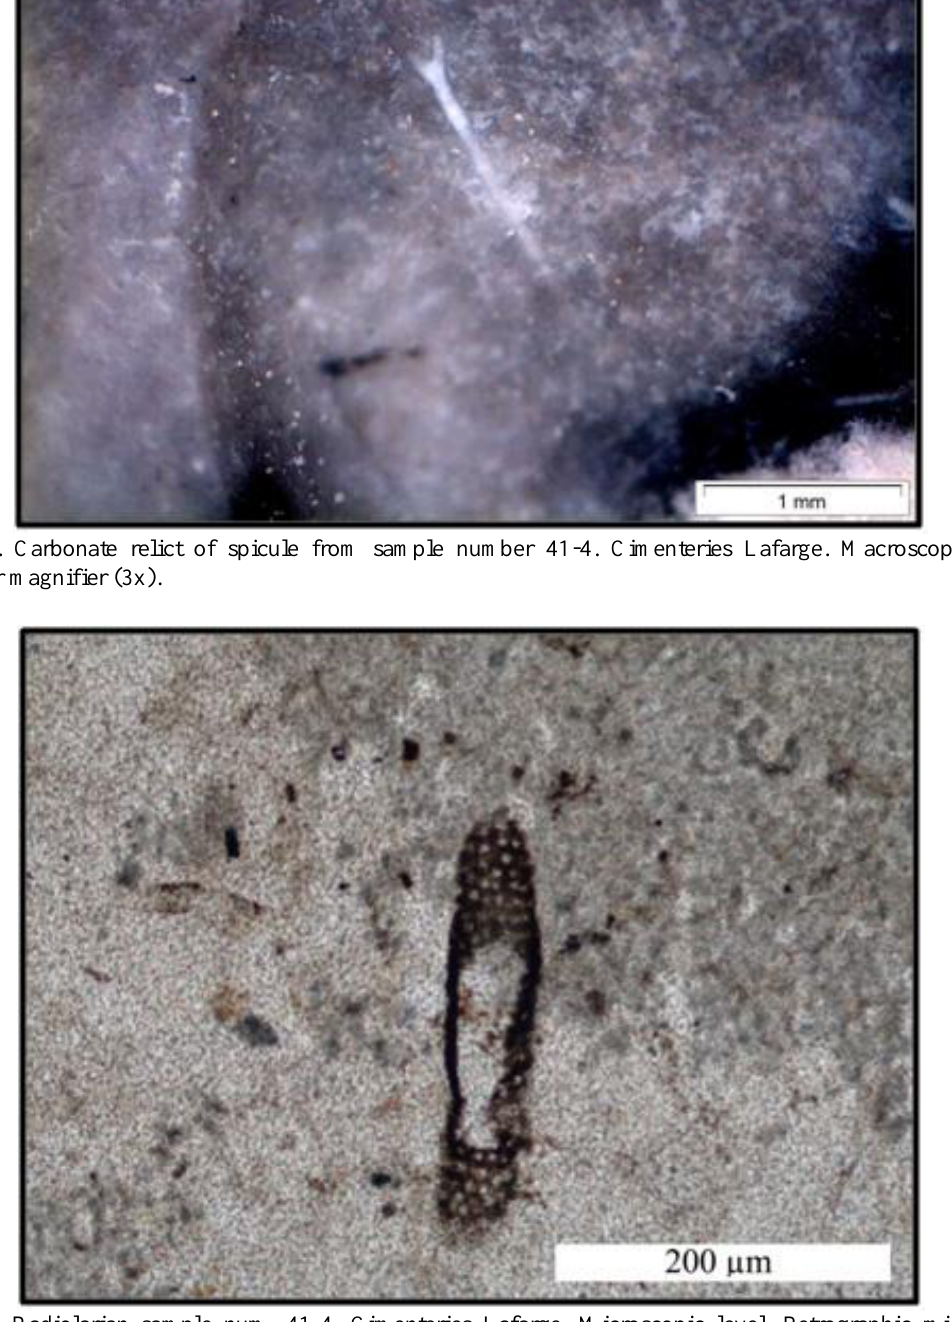
Figure 4. Radiolarian sample num. 41-4. Cimenteries Lafarge. Microscopic level. Petrographic microscope